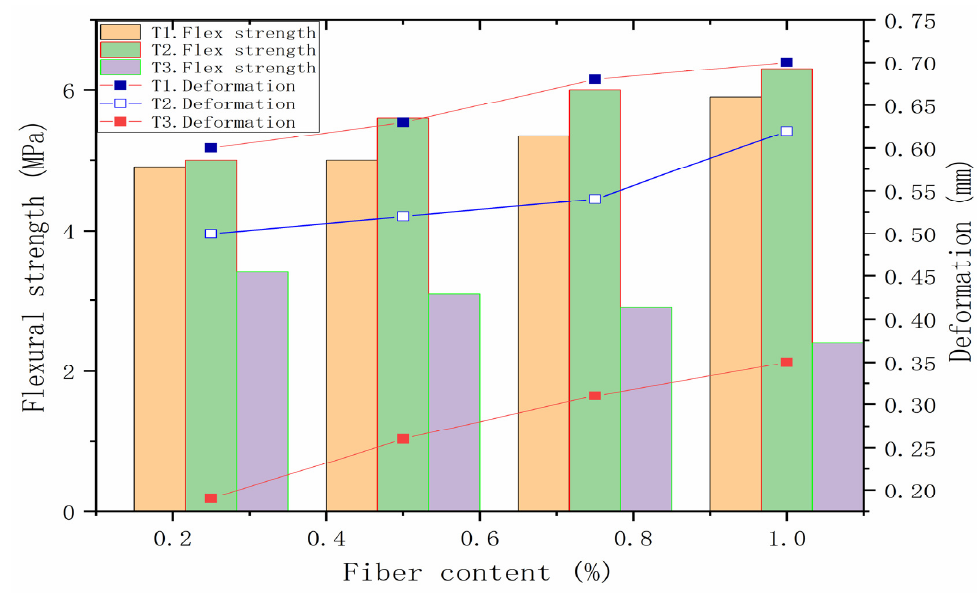
Figure 5. Flexural properties of the geopolymer with 6 mm fiber length. Adapted with permission from [33], copyright 2017 Elsevier.